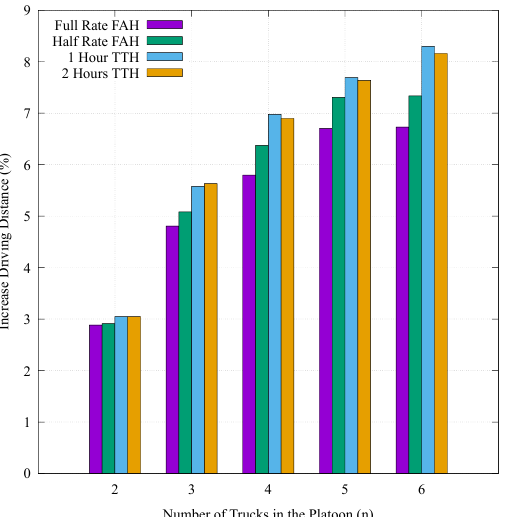
Figure 1. Increased Driving Distance over the Number of Trucks in